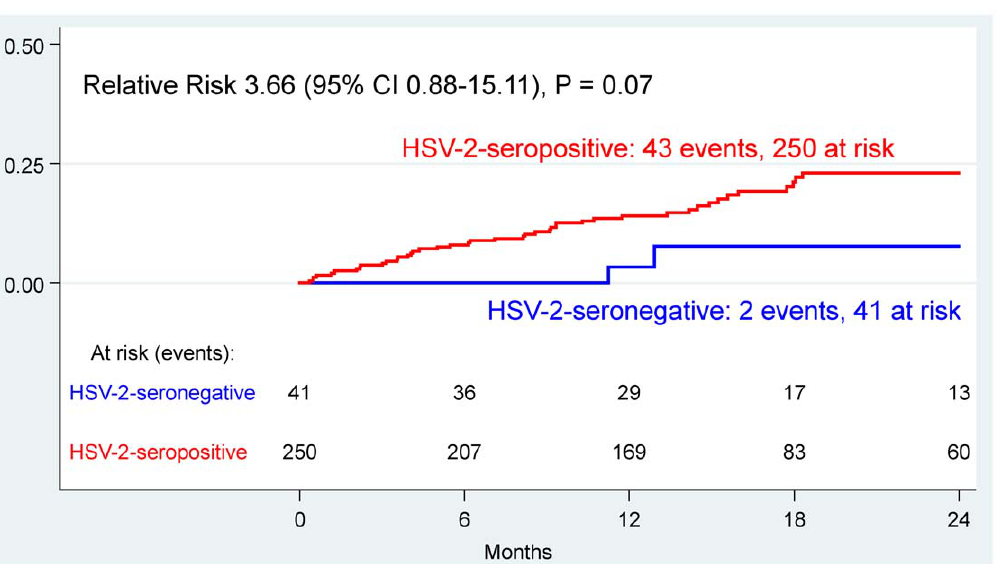
Figure 1. Risk of Opportunistic Infection, by HSV-2 Serostatus (Kaplan-Meier Estimates). Opportunistic infection is defined as: first episode of herpes zoster, Pneumocystis jirovecii pneumonia, tuberculosis, Kaposi sarcoma, meningitis, or encephalitis. Relative risk calculated using Cox regression. Time=months since delivery.